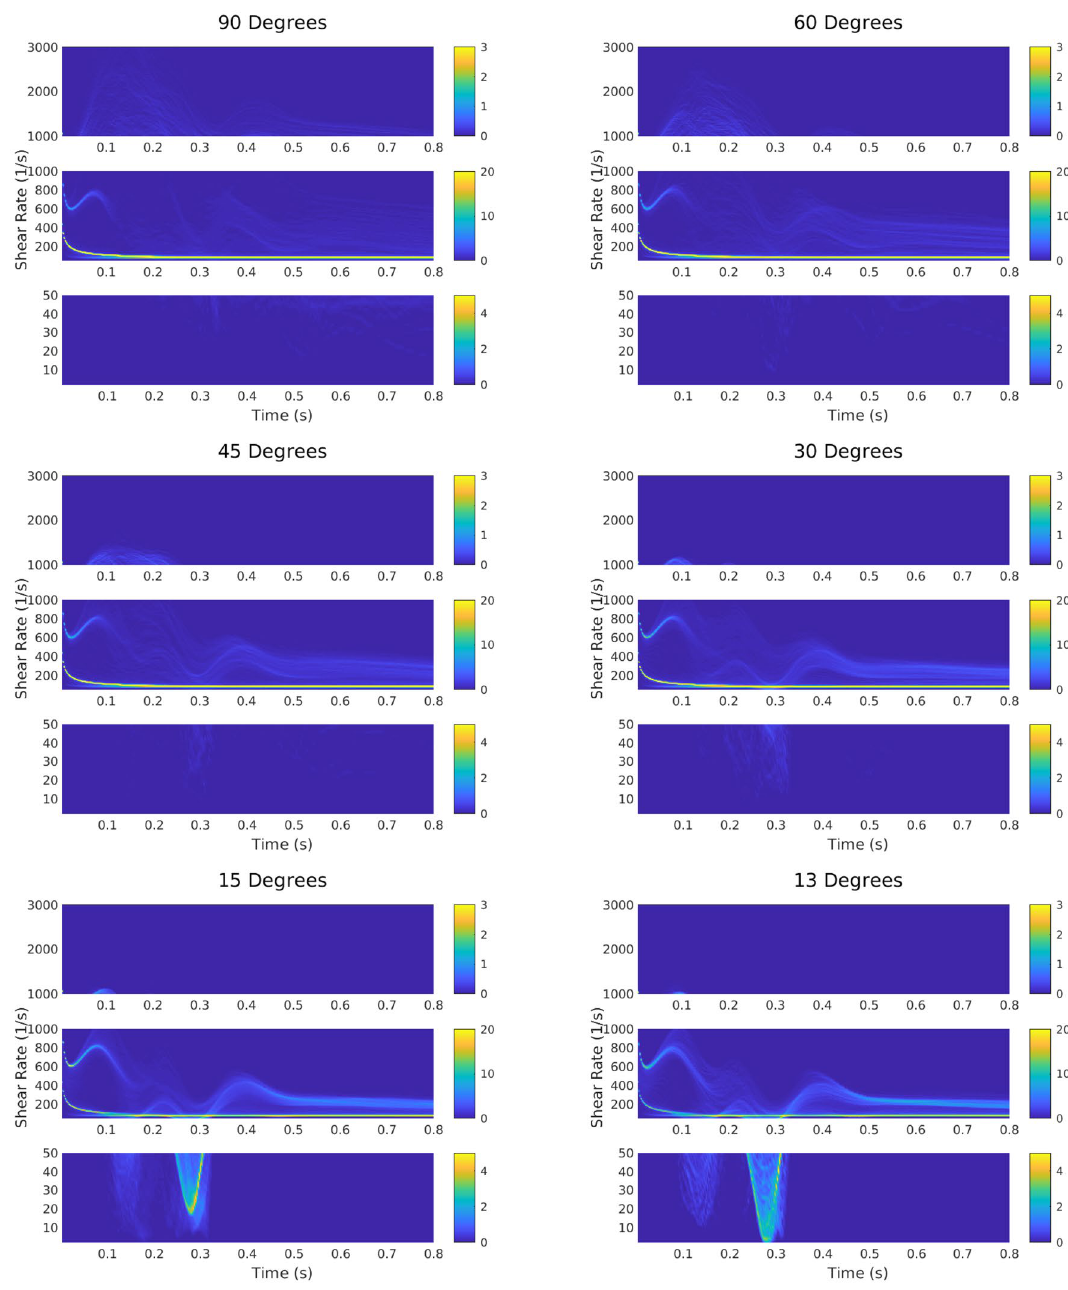
Figure 4. Maps of the percentage of the vein wall experiencing physiological and pathological shear rates over the course of one heart beat, for a range of anastomosis angles. The maps are separated into three sections: pathologically low wall shear rates ( 0 high wall shear rate ( 1000 proximal to the